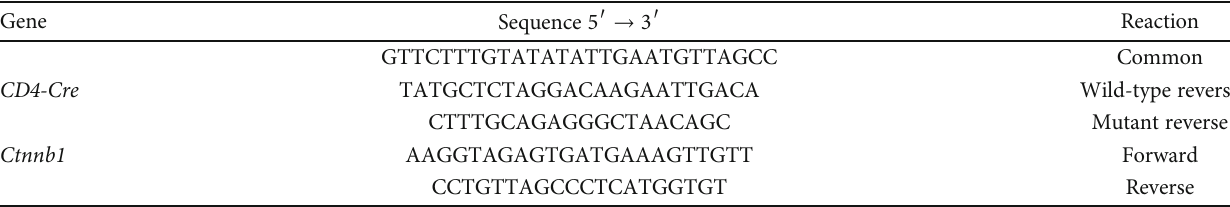
Table 1: Primers used for identi fi